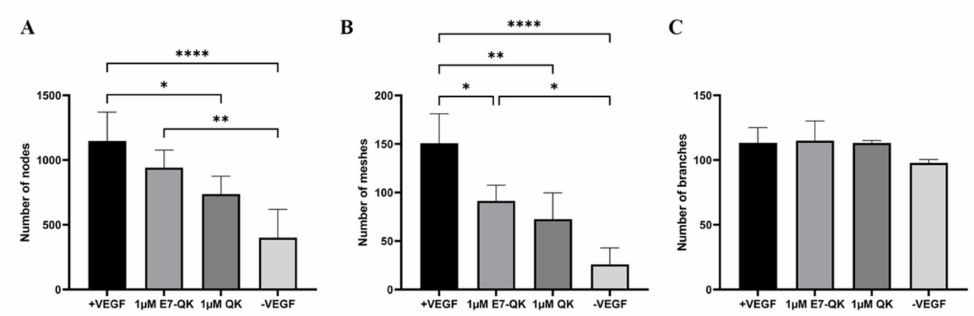
Figure 3. Quantification of tube formation by human umbilical vein endothelial cells in the presence of VEGF and VEGF mimicry peptides (1 µ M). Quantification of fluorescent images was performed with the ImageJ software. Number of nodes ( A ), number of meshes ( B ), number of branches ( C ) formed by HUVECs in the presence of E7-QK (1 µ M), and QK (1 µ M) peptide, or in the presence of VEGF (0.5 ng/mL, positive control group), or without VEGF (negative control group) were compared. Values represent means ± SD from 3 independent experiments (* p < 0.05, ** p < 0.01, **** p <